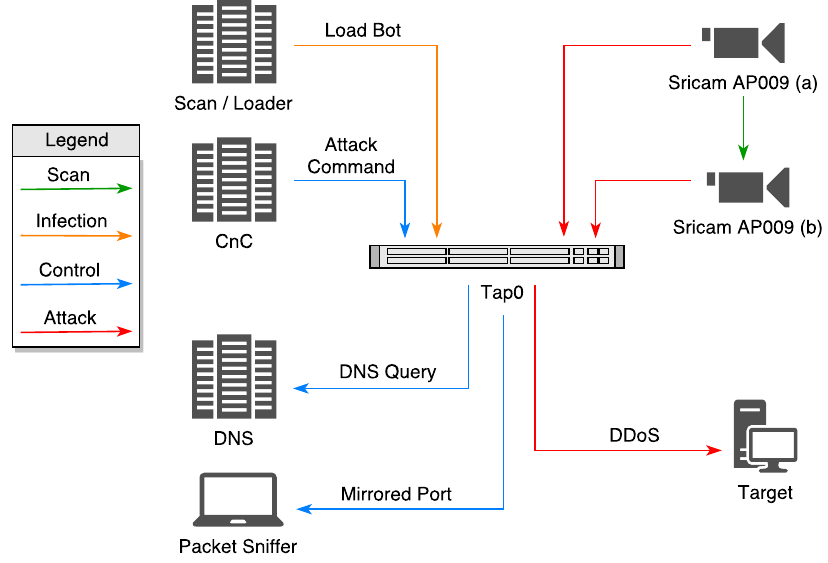
Figure 1. Botnet experimental